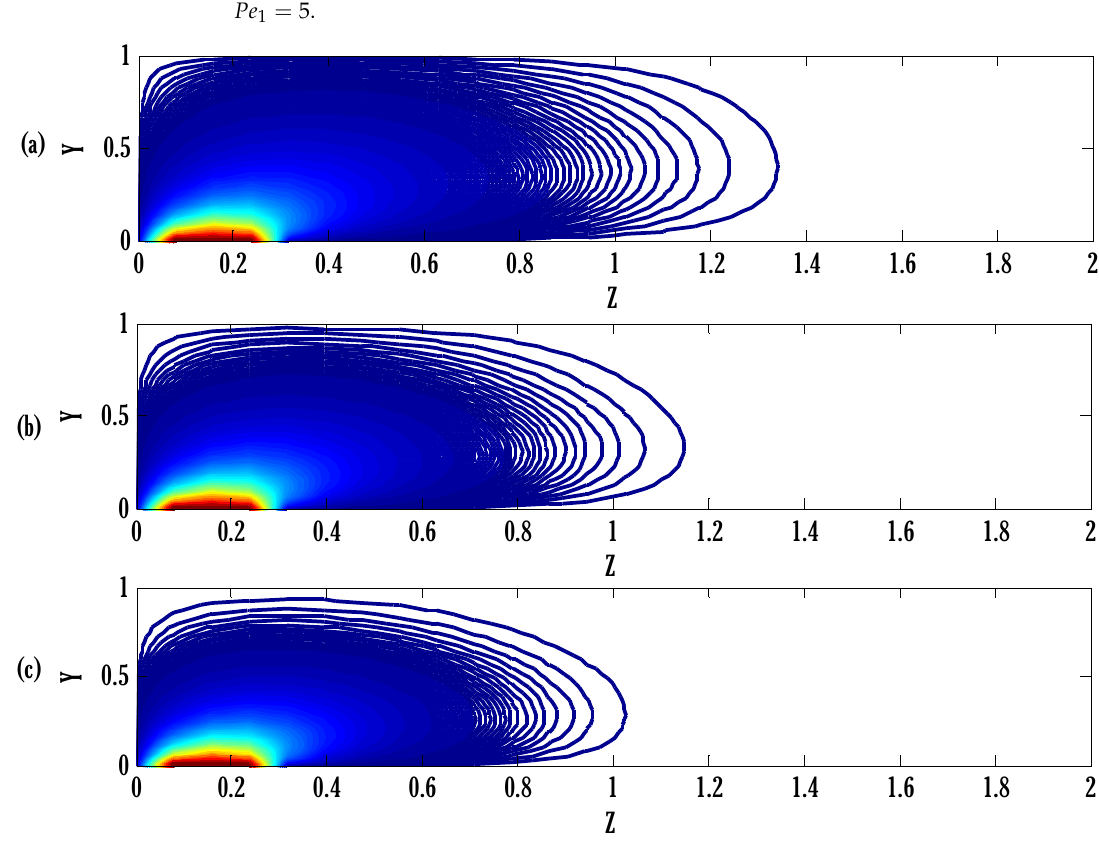
Figure 9. Impact of solutal Péclet number on contours of concentration at (𝐚) 𝑃𝑒 (cid:2870) = 10 , (𝐛) 𝑃𝑒 (cid:2870) = 15 , (𝐜) 𝑃𝑒 (cid:2870) = 20 using 𝑁 (cid:3099) = 3000, 𝑁 (cid:3026) = 40,𝑁 (cid:3027) = 900, 𝛾 = 4, 𝑡 (cid:3033) = 1 .